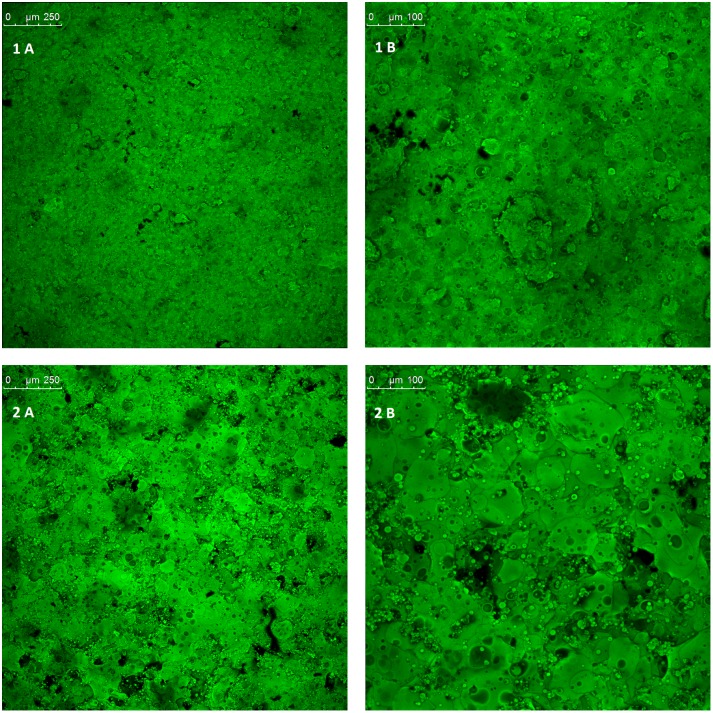
Maximum projection images of the film coat surface, providing a visual representation of surface morphology and film coat uniformity.Aqueous film coat consisting of Kollicoat IR 20% w/w and riboflavin 5’-monophosphate sodium 0.5% w/w as a fluorescent dye. Tablets coated by fluidised bed coating method at defined droplet sizes: 20μm (1) and 70 μm (2). Images were taken at 10x (A) and 25x (B) magnification.